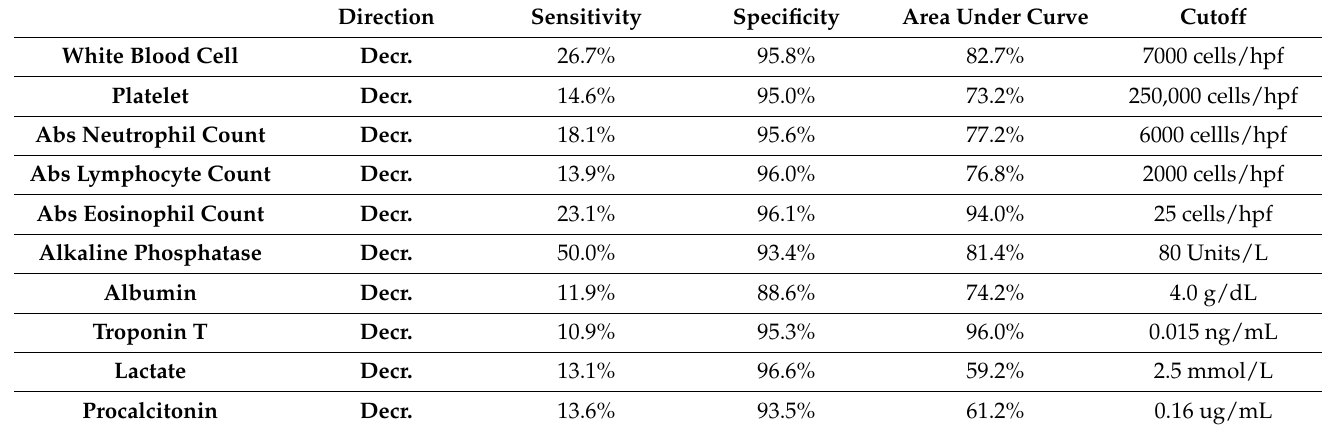
Table 2. Diagnostic Accuracy of Select Laboratory Tests for